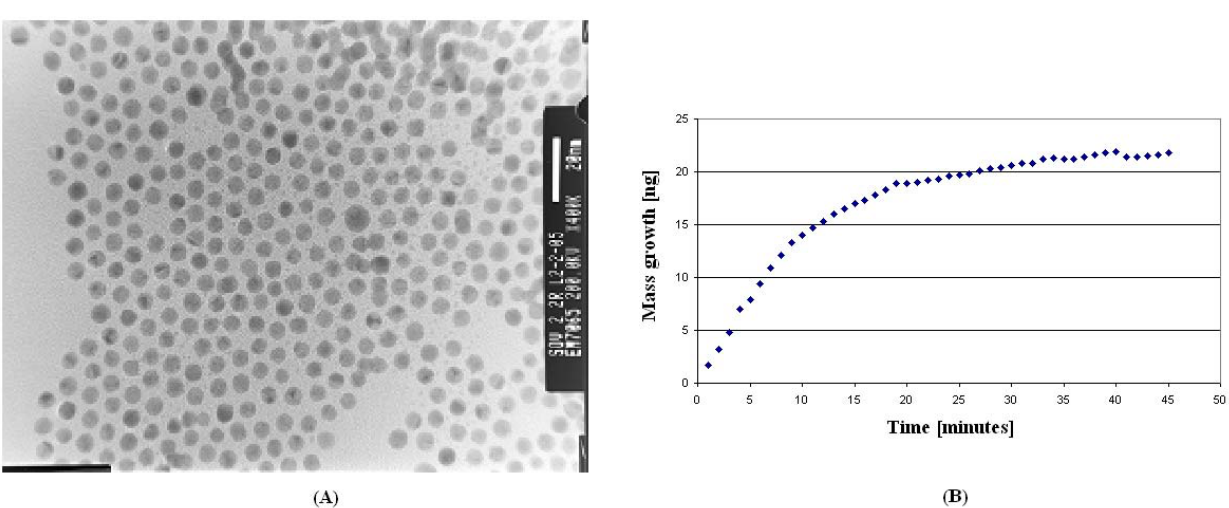
Figure 8. (A) SEM image of thiols capped gold nano-particles with size close to 5 nm. (B) Mass changing during nano-particles formation induced by injection of hydrogen S) inside a Langmuir-Blodgett multi-layer made of cadmium sulfide (H 2